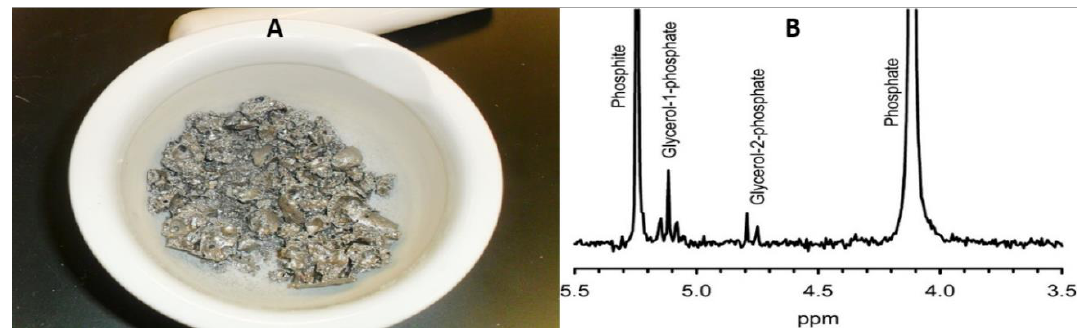
Figure 11. ( A ) synthesized schreibersite (Fe 2 NiP) [137] or its synthetic analogue (Fe 3 P) were used to phosphorylate glycerol under Hadean conditions in the ( B ) 31 P-NMR spectrum [143]. The picture of schreibersite was reproduced and reprinted with permission from [137]; Copyright © 2017 Elsevier while the 31 P-NMR figure shows glycerol phosphorylation by Fe 3 P [143]; Copyright © 2013 National Academy of